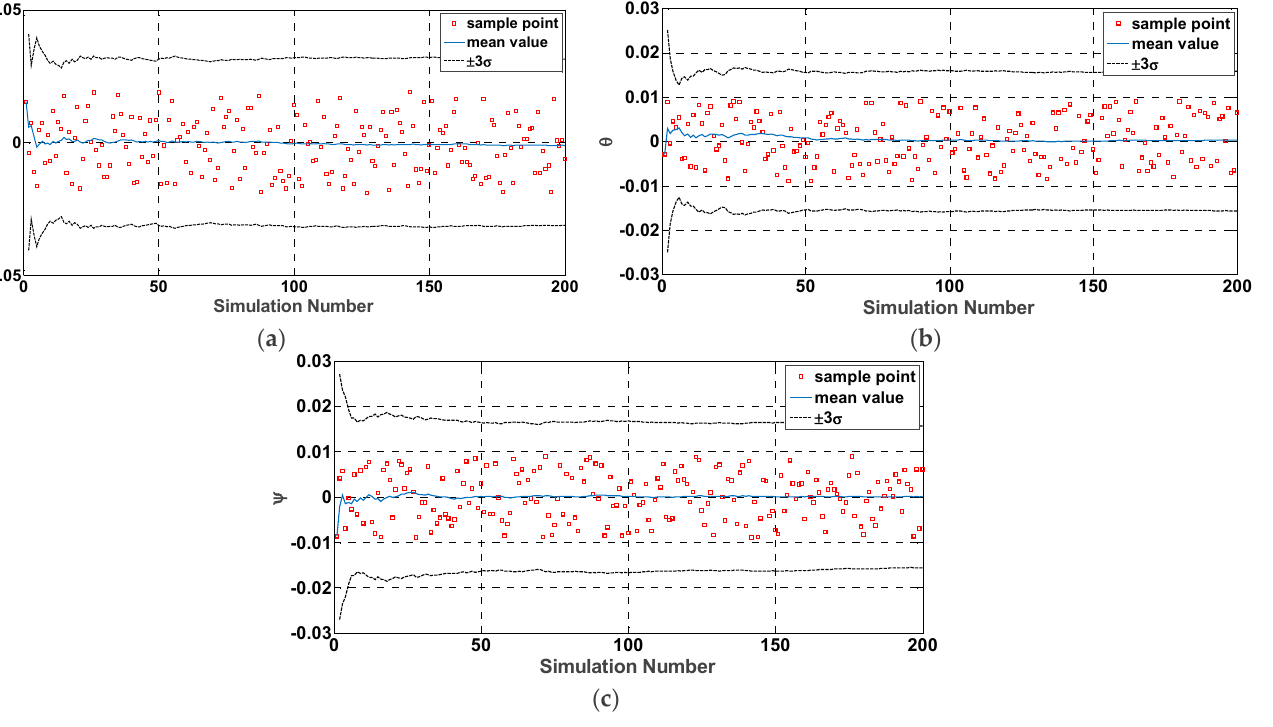
Figure 13. Monte-Carlo simulation error for ( a ) φ , ( b ) θ , and ( c ) ψ .